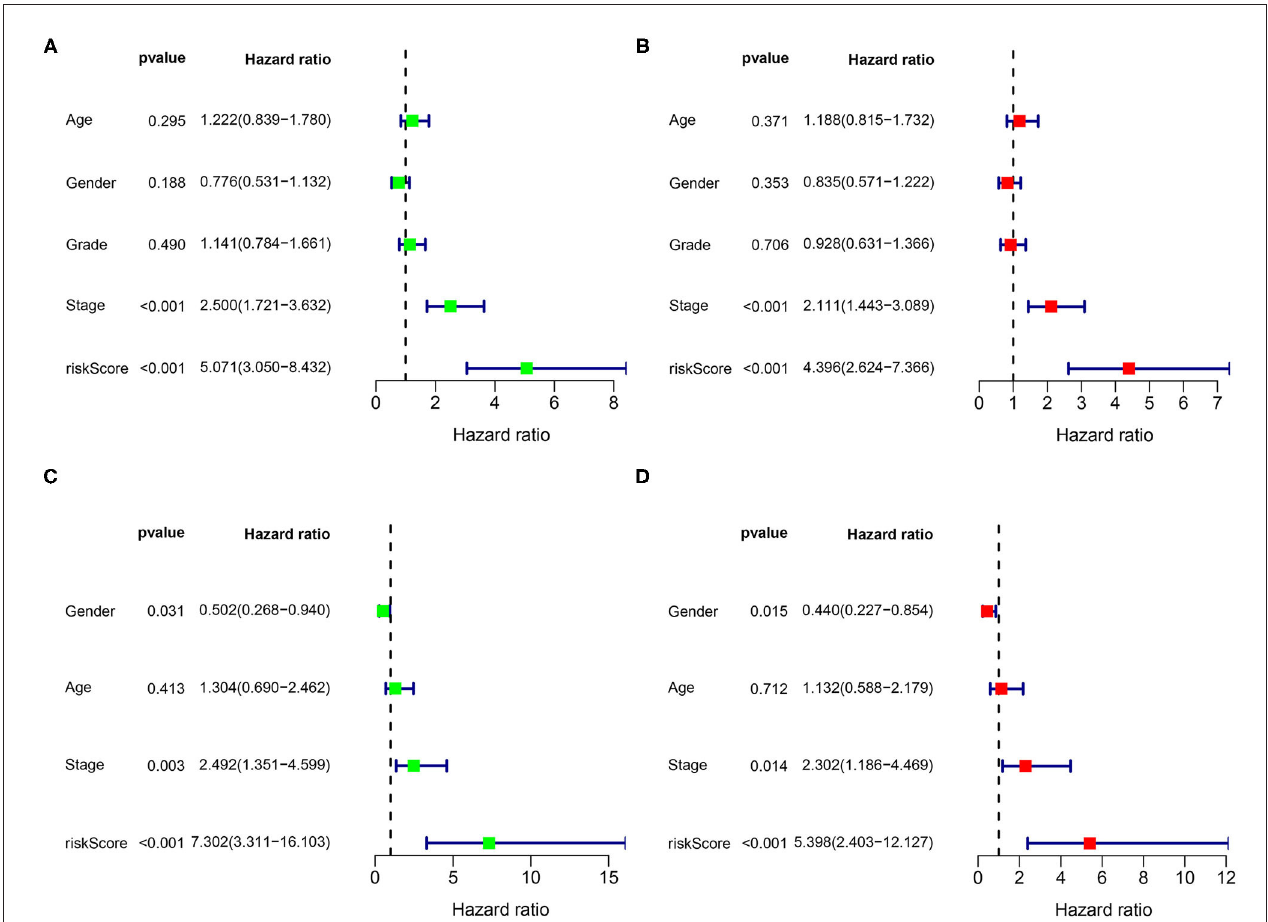
FIGURE 7 | Univariate and multivariate analysis for the identification of the predictive factors. The forest plots of (A) the univariate and (B) multivariate results show that the risk score [hazard ratio (HR) 5.071, 95% CI 3.050, 8.432; HR 4.396, 95% CI 2.624, 7.366; p < 0.001] and stage (HR 2.500, 95% CI 1.721, 3.632; HR 2.111, 95% CI 1.443, 3.089; p < 0.001) are associated with poor prognosis in the TCGA dataset. The forest plots of (C) the univariate and (D) multivariate analysis in the ICGC